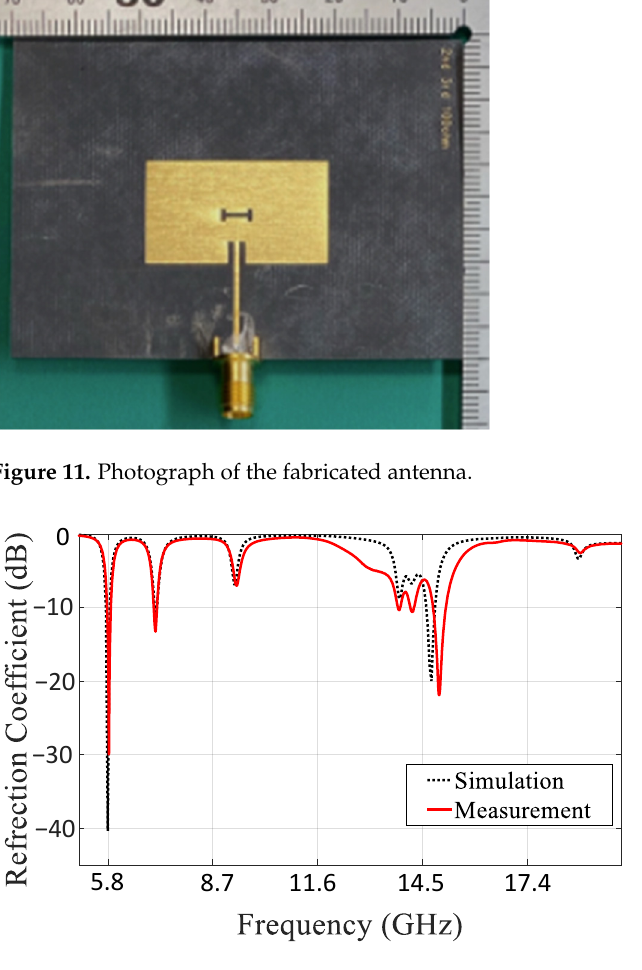
Figure 12. Reflection coefficient of the proposed patch antenna (measurement and simulation).